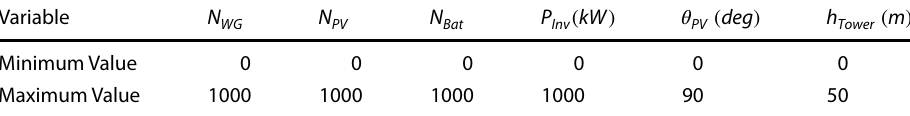
Table 2 Range of changes in optimization variables for PV/ WT/Batt system